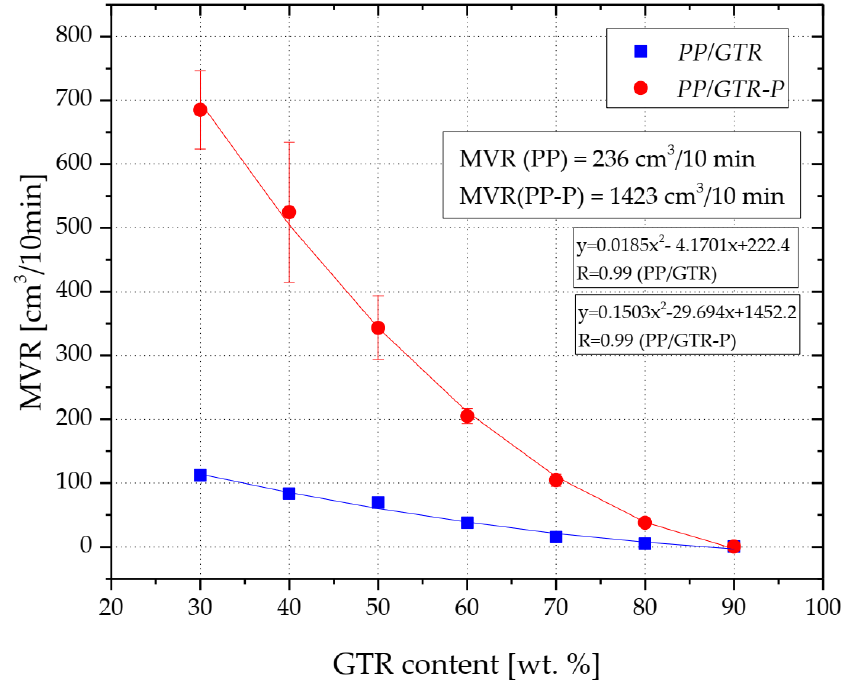
Figure 6. Influence of GTR content on MVR of PP/GTR compounds .